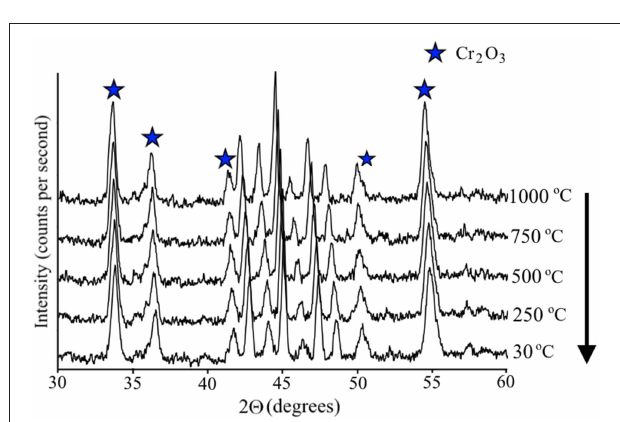
FIGURE 3 | Non-ambient XRD data from FeSiVCr, showing single-phase BCC at room temperature up to 400 ◦ C; BCC to tetragonal phase transition from 400 ◦ C, and formation of C r 2O 3 at 600 ◦ C. The triangles indicate peaks attributed to a tetragonal phase, isostructural with FeCr 0.5 V 0.5 . The stars indicate peaks attributed to Cr 2 O 3 .